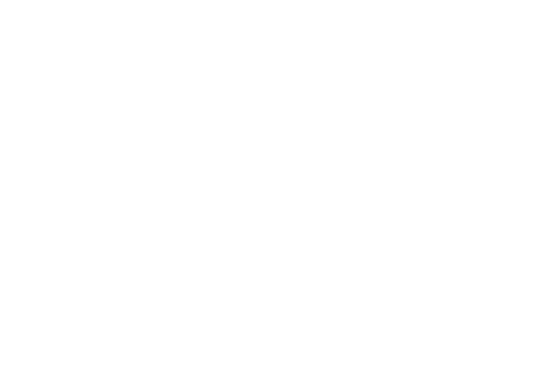
Table 4. The curing and mechanical properties of R-GNP